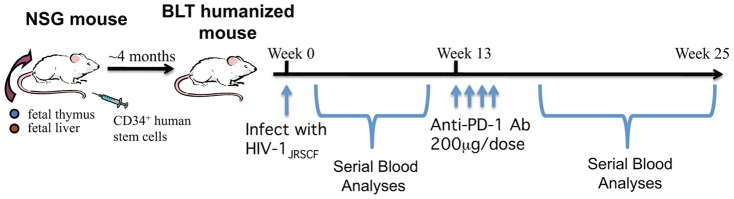
Schematic of BLT humanized mouse generation and timeline of HIV-1 infection and anti-PD-1 mAb treatment.